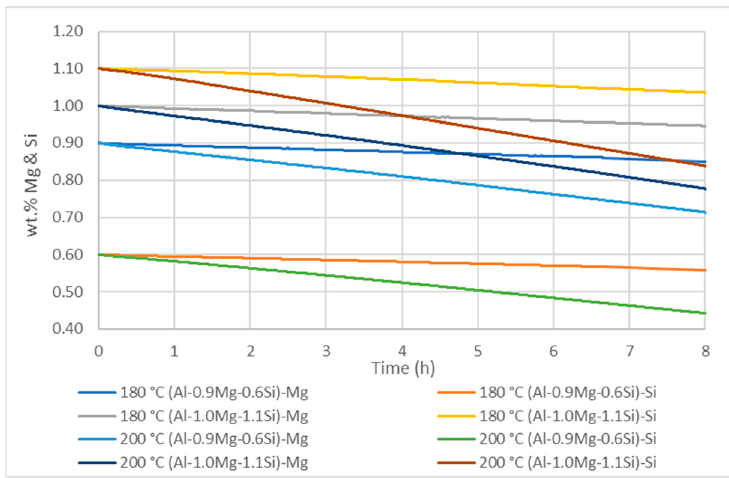
Figure 11. Temporal evolution of Mg and Si content in the matrix phase.